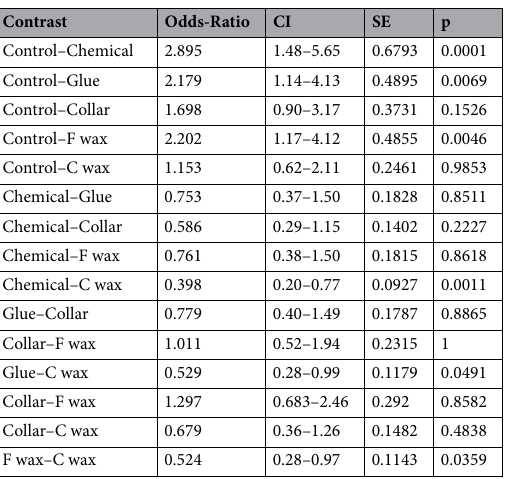
Table 7. Comparison of mortality between treatments at the clear-cut site based on the Tukey method for comparing family estimates. The log odds were exponentiated to obtain the odds-ratios (OR).